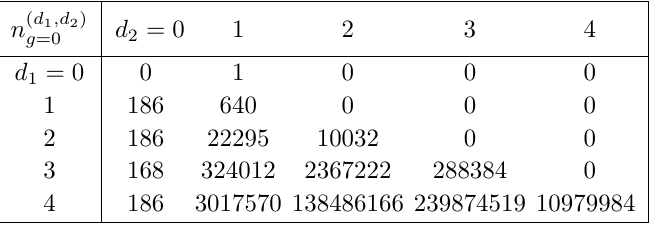
Table 6 . Genus 0 GV-invariants associated to X (2)